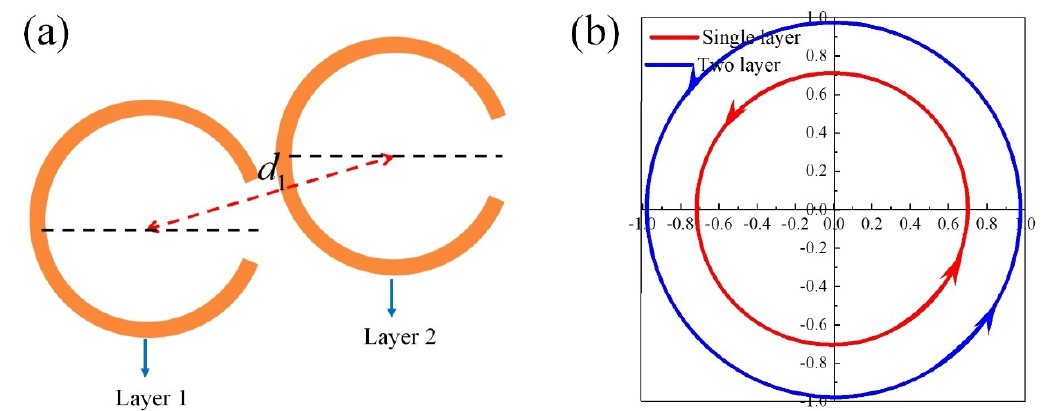
γ α r w , , , ) = (39 µm, 60°,